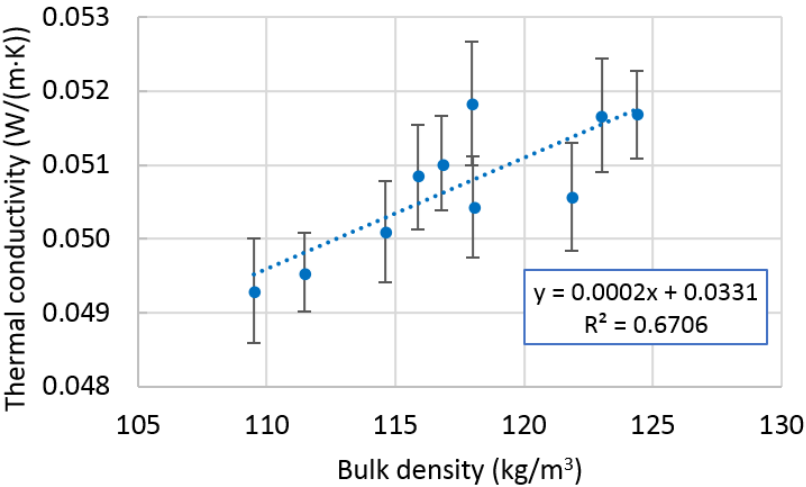
Figure 6. Thermal conductivity of hemp shives for different achieved bulk densities of samples (error bars mean standard deviation) .